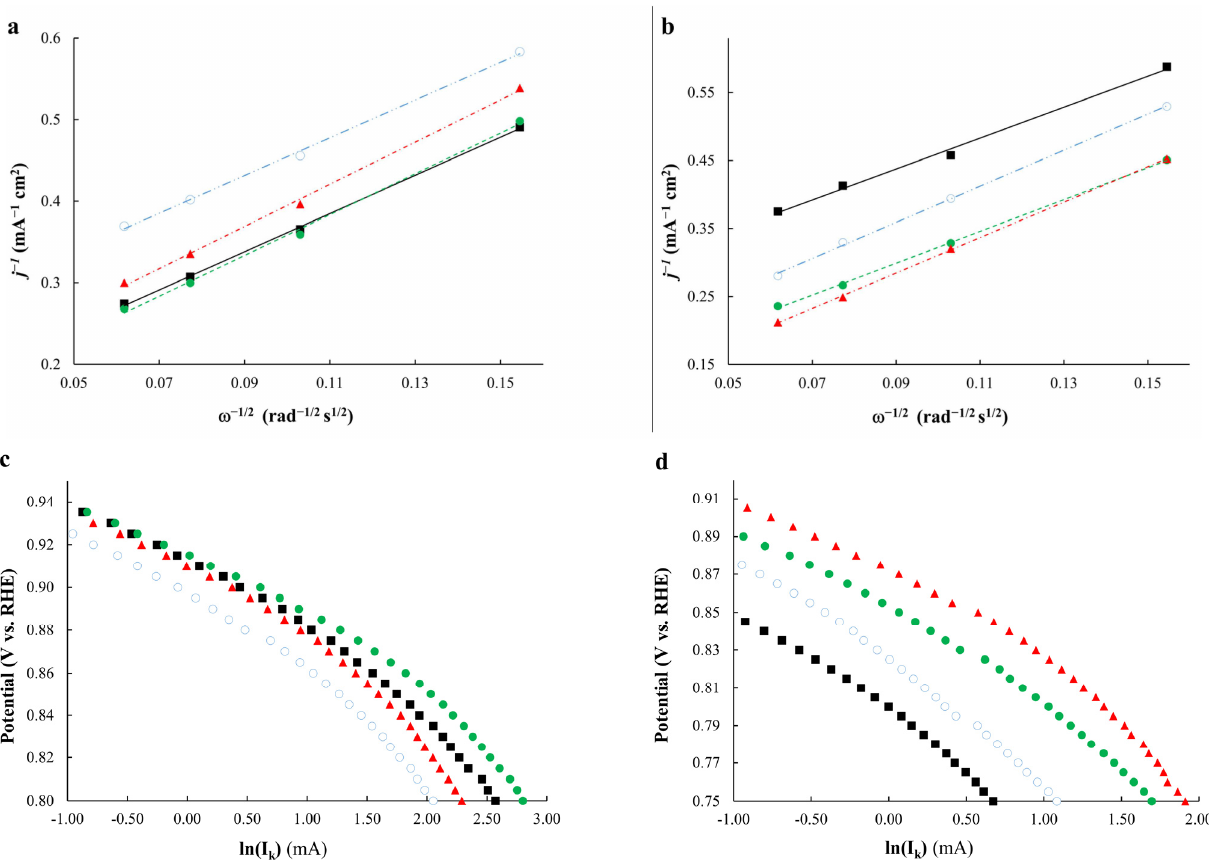
Figure 7. The Koutetsky − Levich dependence at a potential of 0.90 V before stress testing ( a ) and at a potential of 0.80 V after stress testing ( b ); the Tafel dependence before ( c ) and after ( d ) stress testing for the following materials: black − AC, green − AC_acid, red − AC_350, and blue − JM40. Table 3. The electrochemical characteristics of the PtCu/C catalysts after durability